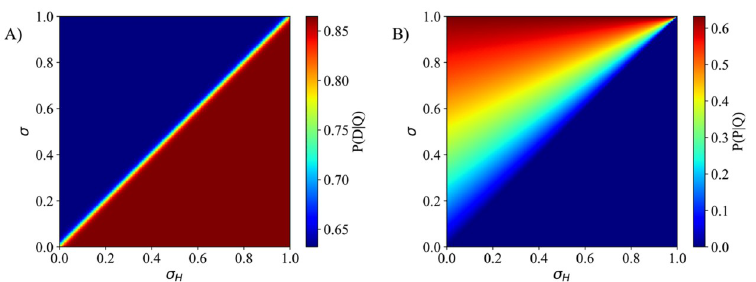
Fig 3. Transition probabilities of quiescent cells. Panels A) and B) present the dynamics of Eqs (13) and (14), respectively. We assume � a ¼ 1 , γ = 1, � a ¼ 1 , and k = 50. In panel A), the apoptosis probability has two constants D D P values, below and above the glucose threshold, while k controls how smooth the transition is between these two constants. The apoptosis probability when σ > σ is proportional to � a , and proportional to � a þ g when σ < σ . In H H D D D panel B), if the glucose concentration, σ , is below σ H , the proliferation probability is equal to zero. However, if σ > σ H , the probability increases as the glucose concentration